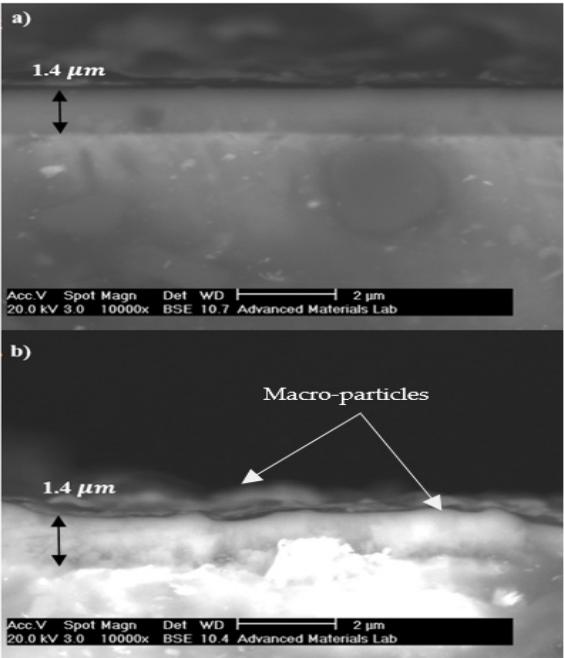
Figure 7. SEM images of the cross-sections of ( a ) CrN-coated layer and ( b ) TiN-coated layer.